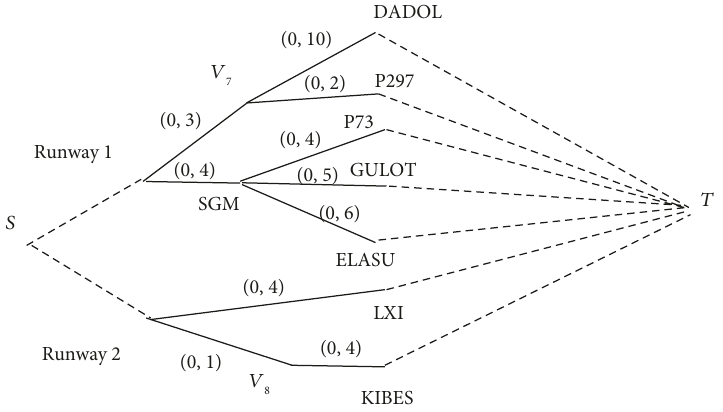
Figure 8: Departure route network with capacity under meteorological in fl uence